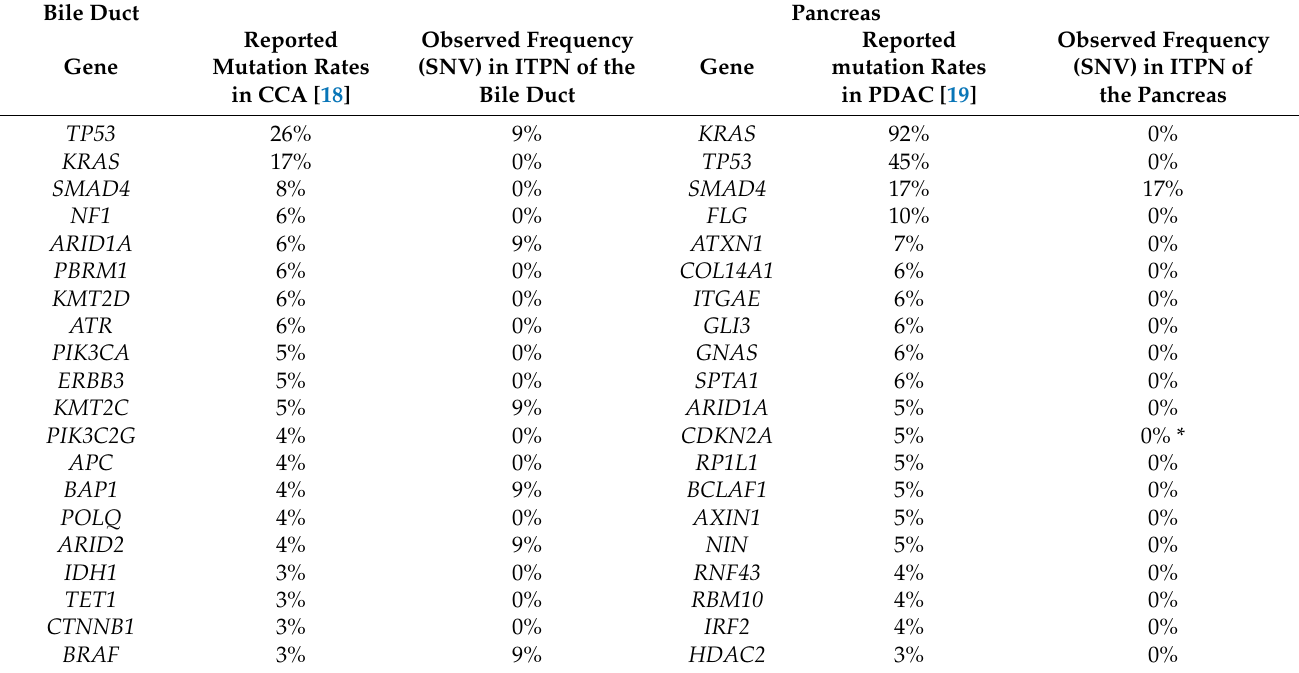
Table 1. Comparison of identified alterations in ITPNs, with reported mutation rates of classical pancreato-biliary adenocar- cinomas. List of reported most common mutated genes in cholangiocarcinoma (CCA) [18] (left side) and pancreatic ductal adenocarcinoma (PDAC) [19] (right